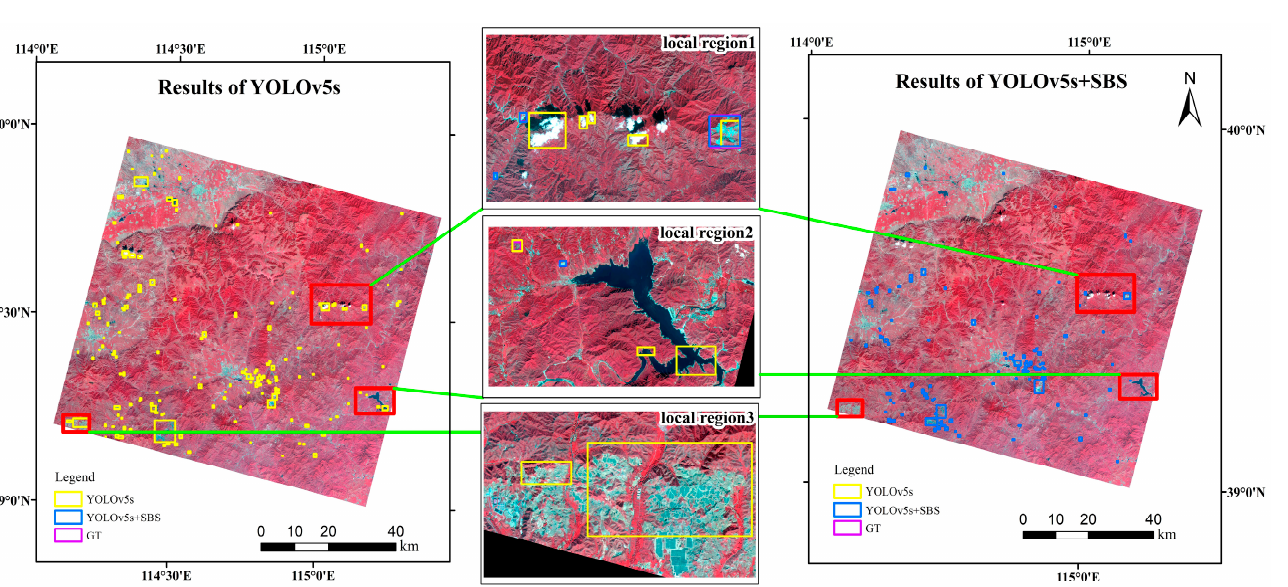
Figure 13. Ground truth on the entire GF-6 images.